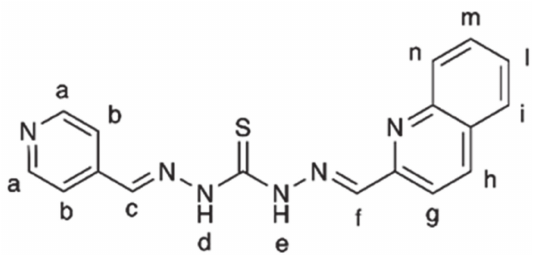
Figure 7. Quinoline-2-carboxaldehyde-pyridine-4-formyl-bisthiocarbohydrazone (L).